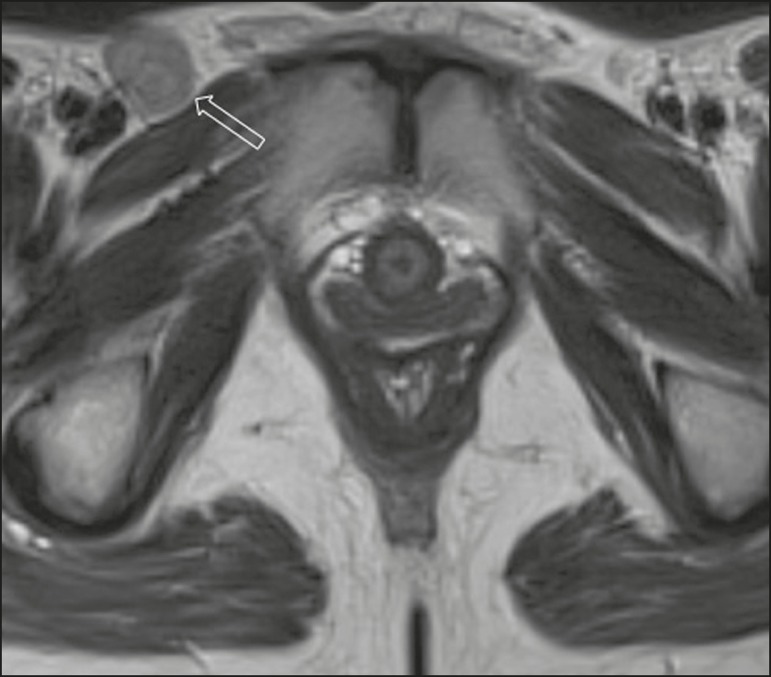
FIGO stage III vulvar carcinoma. Axial T2WI showing an enlarged right
inguinal lymph node (open arrow). Fine needle aspiration cytology of
the lymph node confirmed the presence of tumor cells within the
node.